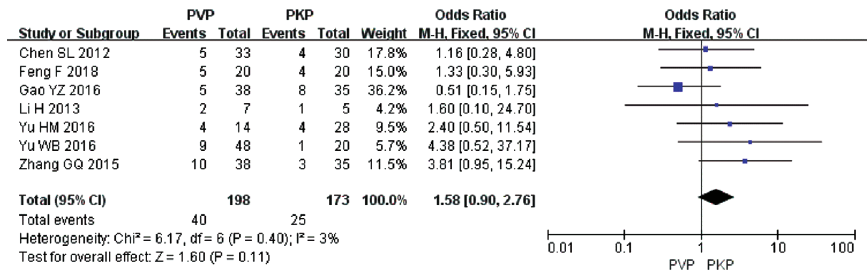
Figure 7. Forest plot to assess cases of cement leakage between the two procedures.